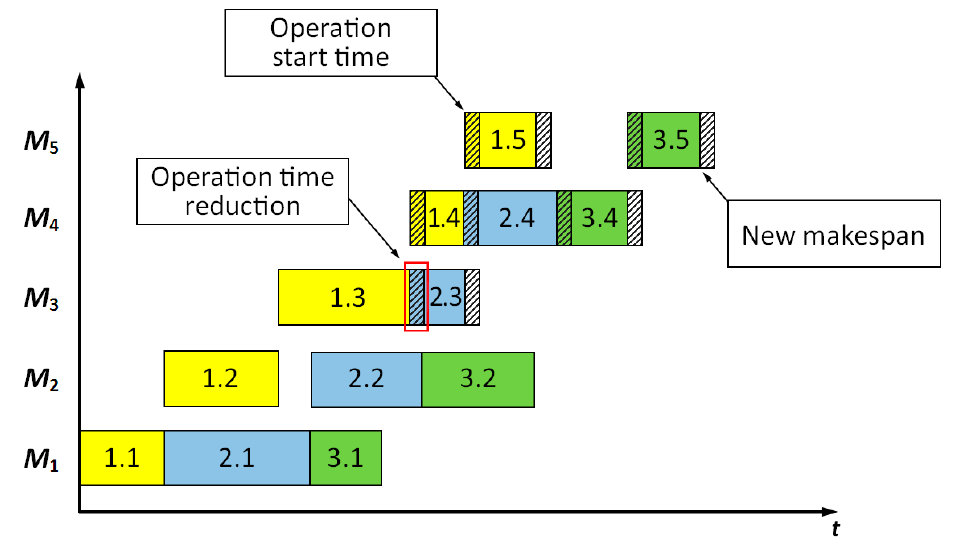
Figure 7. Time reduction for a robotic operation—influence on other processes.